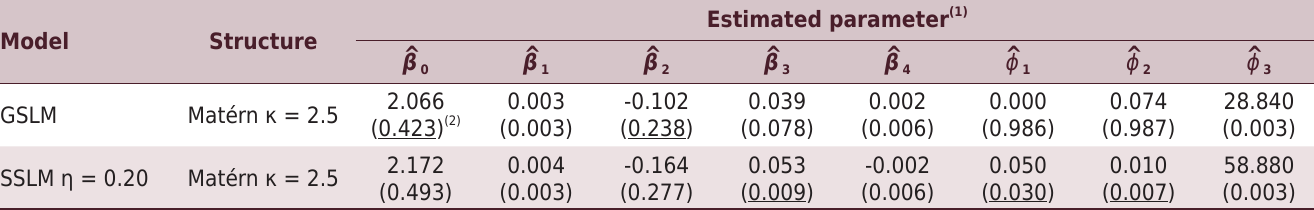
Table 4. Values of the parameter of kurtosis adjustment (η) and of smoothing (κ) selected by CrV (Cross-validation) and Tr (Trace) criteria; estimated values of parameters of the Gaussian spatial linear model (GSLM) and slash spatial linear model (SSLM) by maximum likelihood using the EM algorithm with respective asymptotic standard deviations (in brackets) after removal of influential